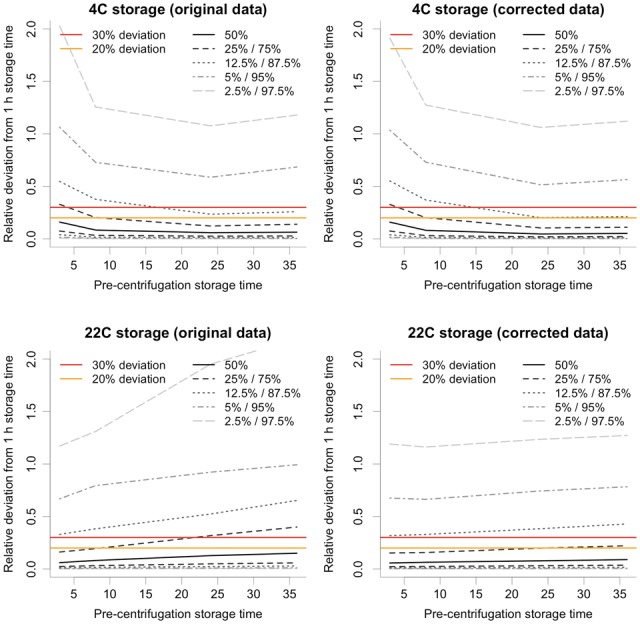
Effects of pre-centrifugation time on metabolite feature stability. The upper graphs show the effects of pre-centrifugation delay time at 4 °C as relative deviation of metabolite feature intensities compared with the reference level (at 1 h) for original data (left) and after data correction based on metadata information (right). Isobaric lines correspond to percentiles in the distribution of relative differences of 7648 measurements (16 samples × 478 features). The lower graphs show corresponding effects of pre-centrifugation delay time at 22 °C. The two horizontal lines correspond to 20% (lower line) and 30% (higher line) absolute deviation in feature intensity from the 1 h reference state